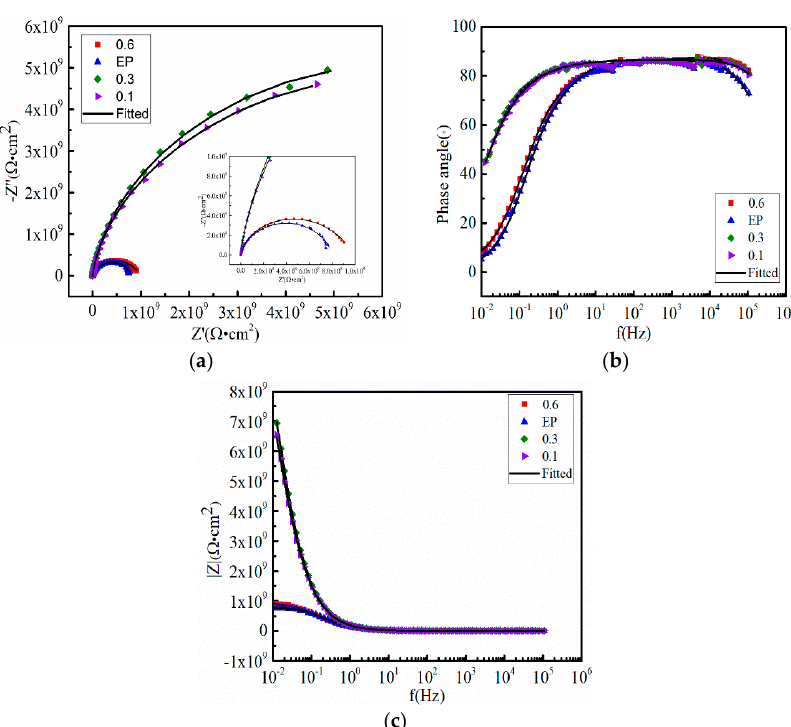
Figure 6. Nyquist and Bode diagrams of composite coatings coated with different ration of TPG ( a – c ) after immersion for 120 h in 3.5% NaCl solution.